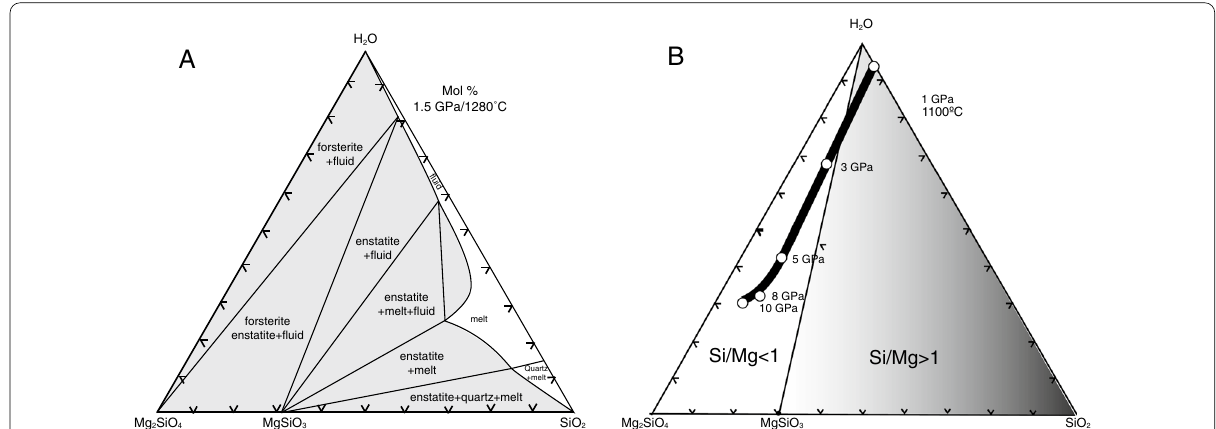
Fig. 15 A. Phase relations in the system Mg 2 SiO 4 –SiO 2 –H 2 O at 1280 °C and 1.5 GPa. B. Evolution of fluid composition in the system Mg 2 SiO 4 –SiO 2 – H 2 O as a function of pressure. Modified from Nakamura and Kushiro (1974) (A) and Mibe et al. (2002)